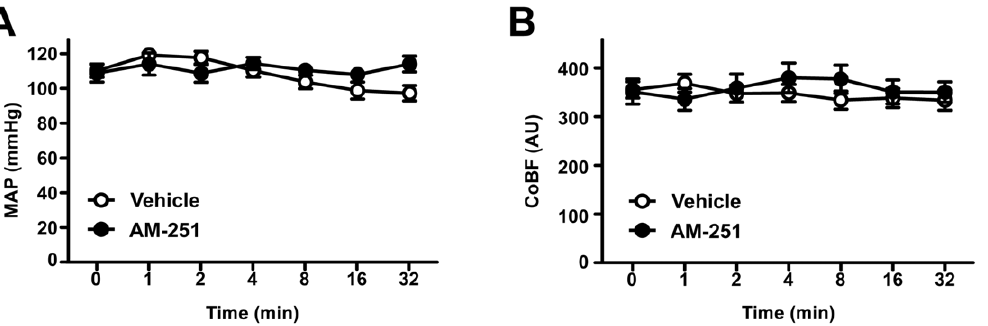
Figure 1. The effects of CB1-receptor blockade on mean arterial pressure (A) and cerebrocortical blood flow (B). Mean arterial pressure N (MAP, n=10) and cerebrocortical blood flow (CoBF, n=20) are shown before (0 min) as well as 1, 2, 4, 8, 16 and 32 minutes after intravenous ) or its vehicle ( # ) in urethane-anaesthetized rats. Values are presented as mean 6 SEM. No significant administration of 10 mg kg 2 1 AM-251 ( difference was found with repeated measures analysis of variance and Tukey’s post hoc test. AU, arbitrary unit.